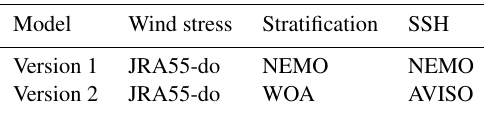
Table 1. The two versions of the linear multi-mode model. NEMO refers to the NEMO model simulation, JRA55-do to the forcing product used to drive the NEMO model (see text for details), WOA to the World Ocean Atlas, and SSH to the sea surface height prod- uct used for fitting in order to determine the weight given to each vertical